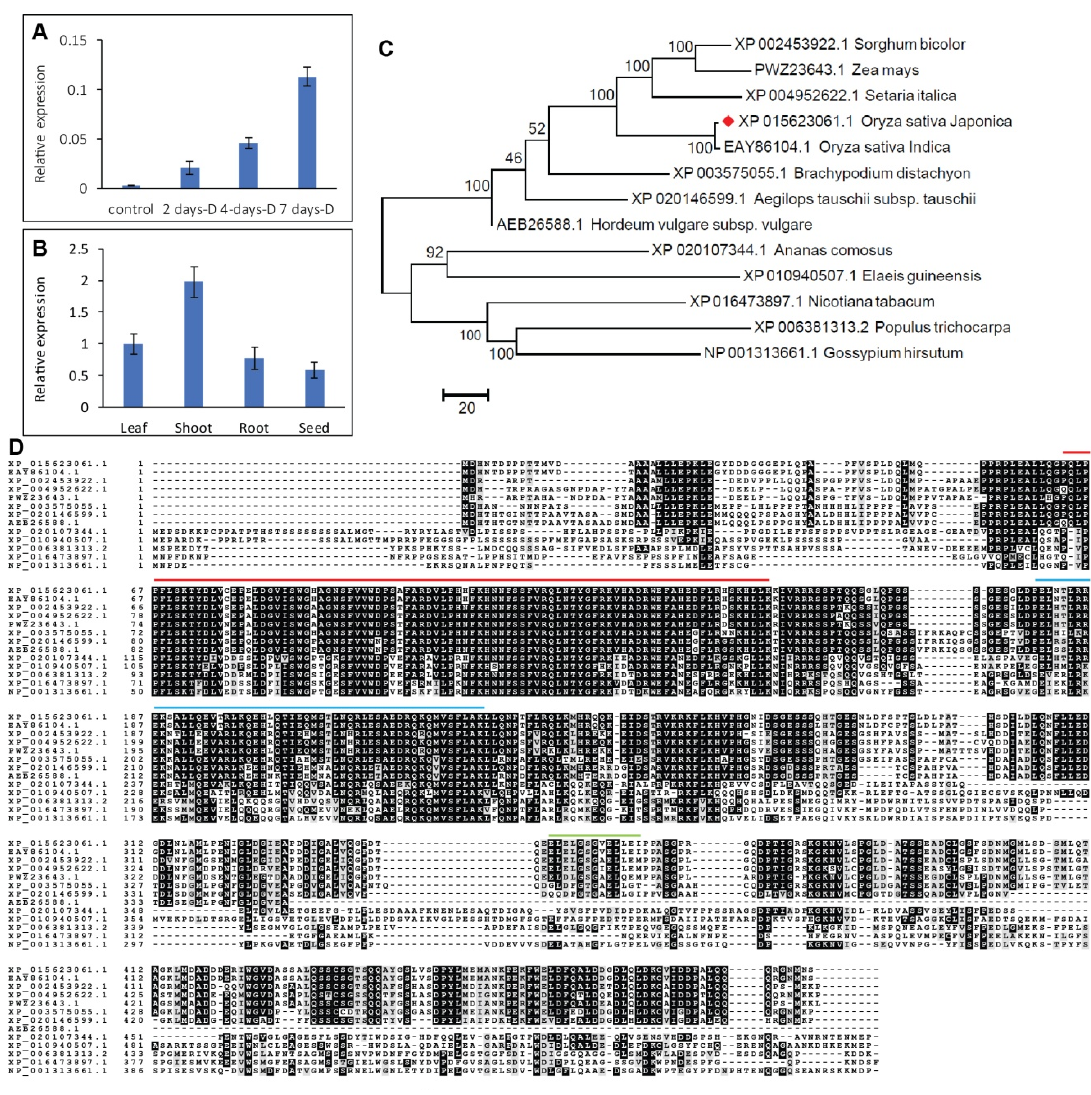
Figure 1. Expression pattern and sequence analysis of OsHSFA3 . ( A ) Relative expression of OsHSFA3 under control and time course drought treatment in rice. ( B ) Relative expression of OsHSFA3 in different rice tissues. ( C ) Maximum likelihood phylogenetic tree based on amino acid sequences of OsHSFA3 and orthologs from different species. Red rhombus is the OsHSF3. ( D ) Multiple sequence alignment showing heat-shock factor (HSF) domain (64–157 aa, under red bar), coiled-coil domain